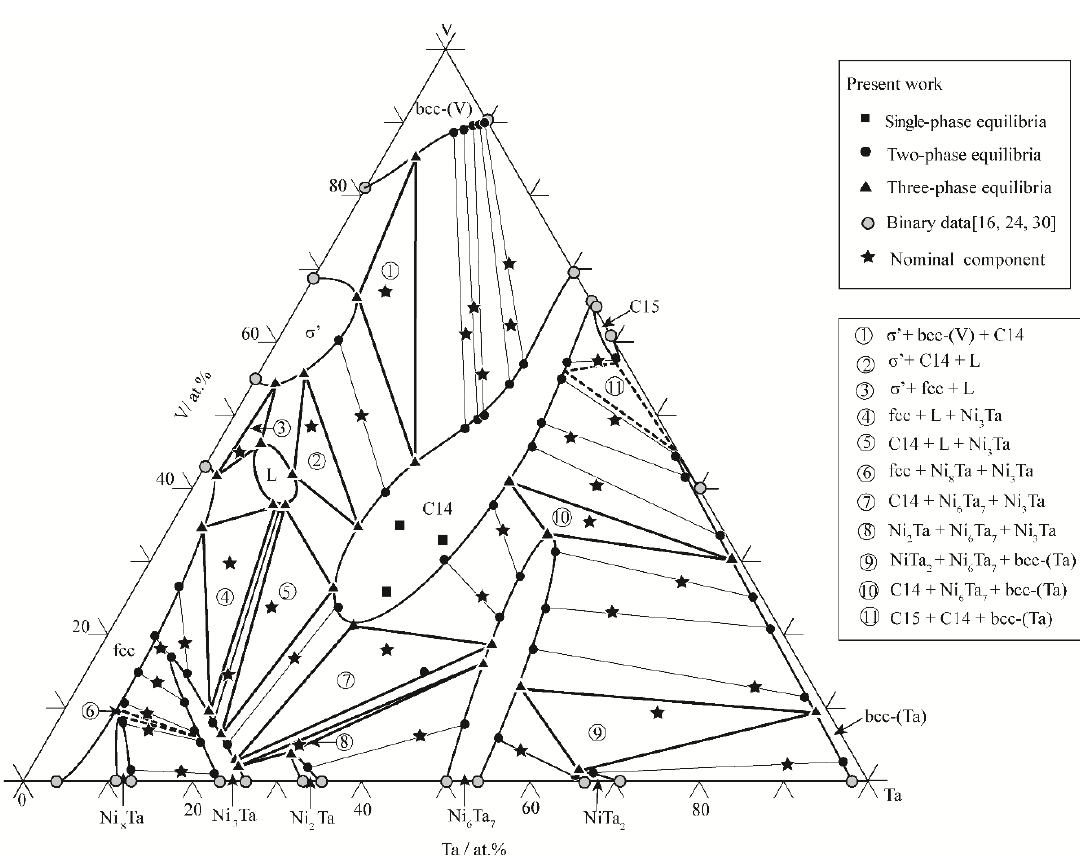
Figure 7. Experimentally determined isothermal section of the Ni-V-Ta system at 1200 °C.